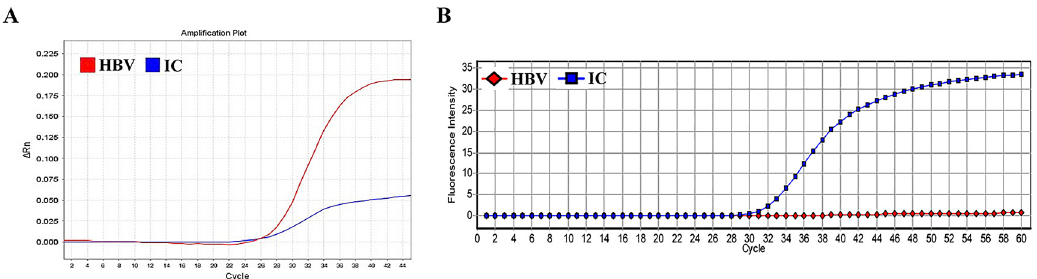
Figure 1: The amplification curves of hepatitis B virus DNA quantification. TheamplificationcurveofHBVisindicatedinredandICisindicatedinblue.(A)HBVDNAquantificationwiththeSansureHBVquantificationkit determined in ABI 7300 Plus on February 9th. (B) The hypersensitive DNA quantification of HBV was measured using the Roche CAP/CTM system on February 12th.